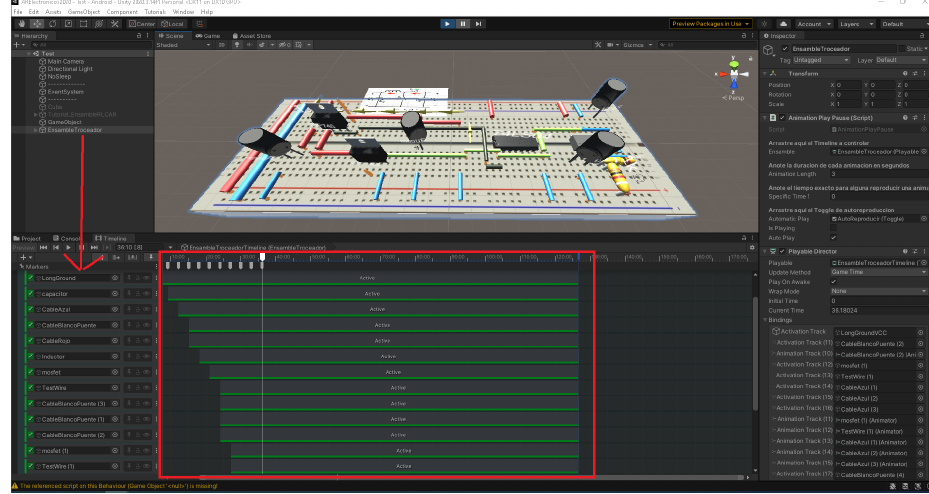
Figure 3. Timeline animations.